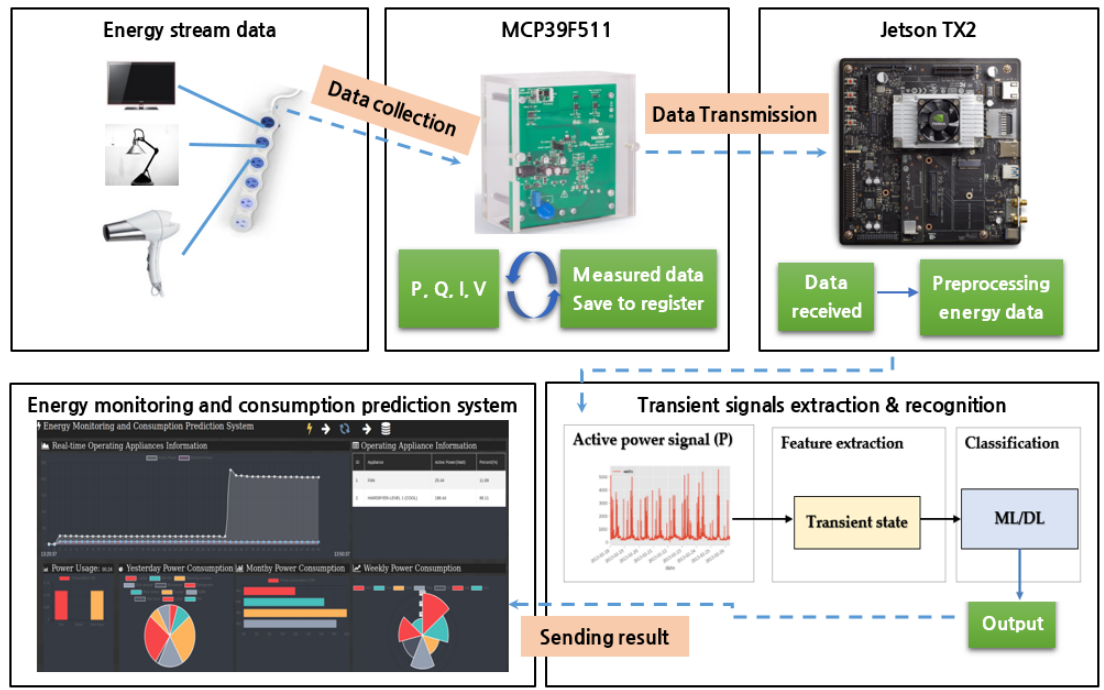
Figure 2. The proposed NILM